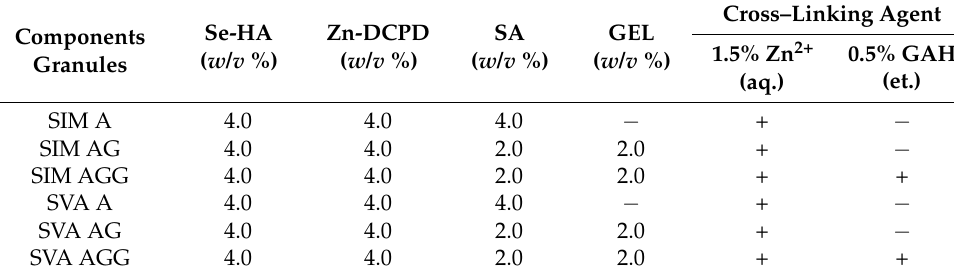
Table 1. The composition of the different types of obtained granules.